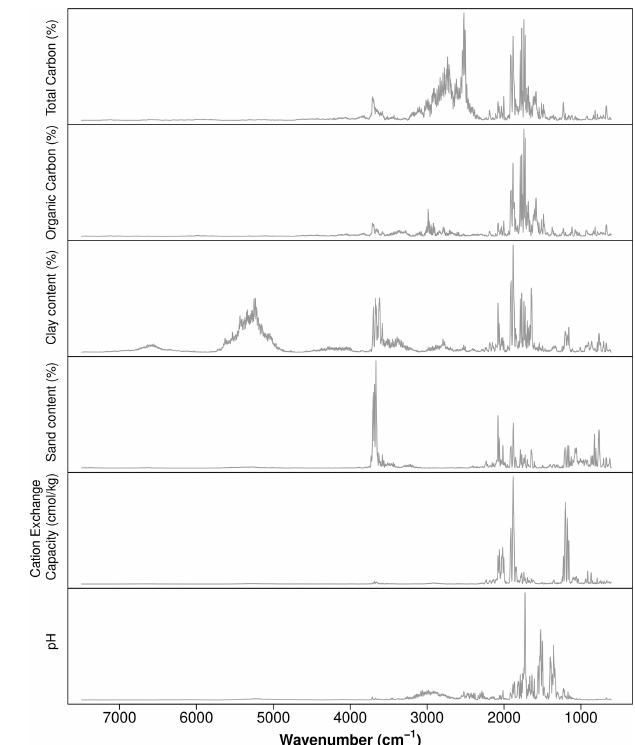
Figure 13. Sensitivity analysis of CNN model prediction as a func- tion of wavelength. Average variance of predictions by wavelength. This analysis allows us to explore the most important wavelengths in a CNN model. Adapted from Ng et al.